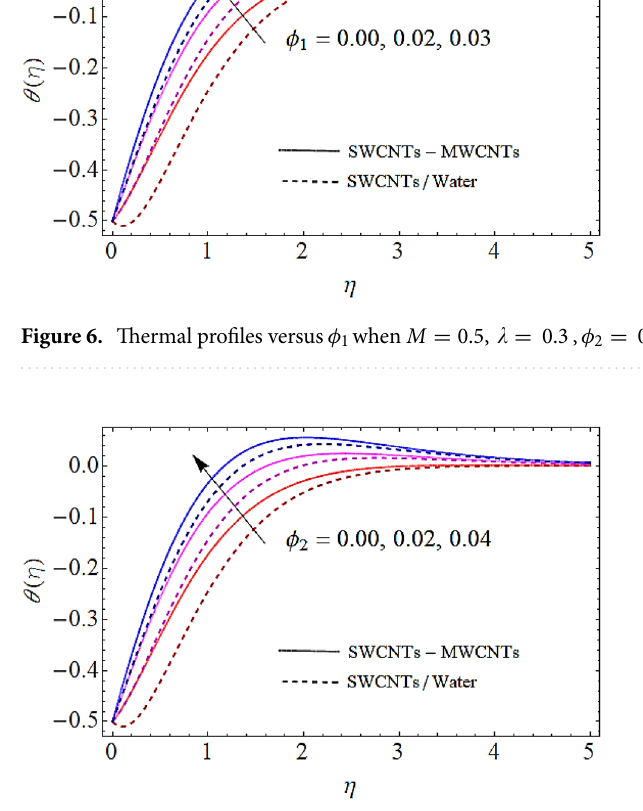
Figure 7. Thermal profiles versus φ 2 when M = 0.5, (cid:31) = 0.3, φ 1 = 0.02, K = 0.7, Pr = 12, R H = 0.6 .